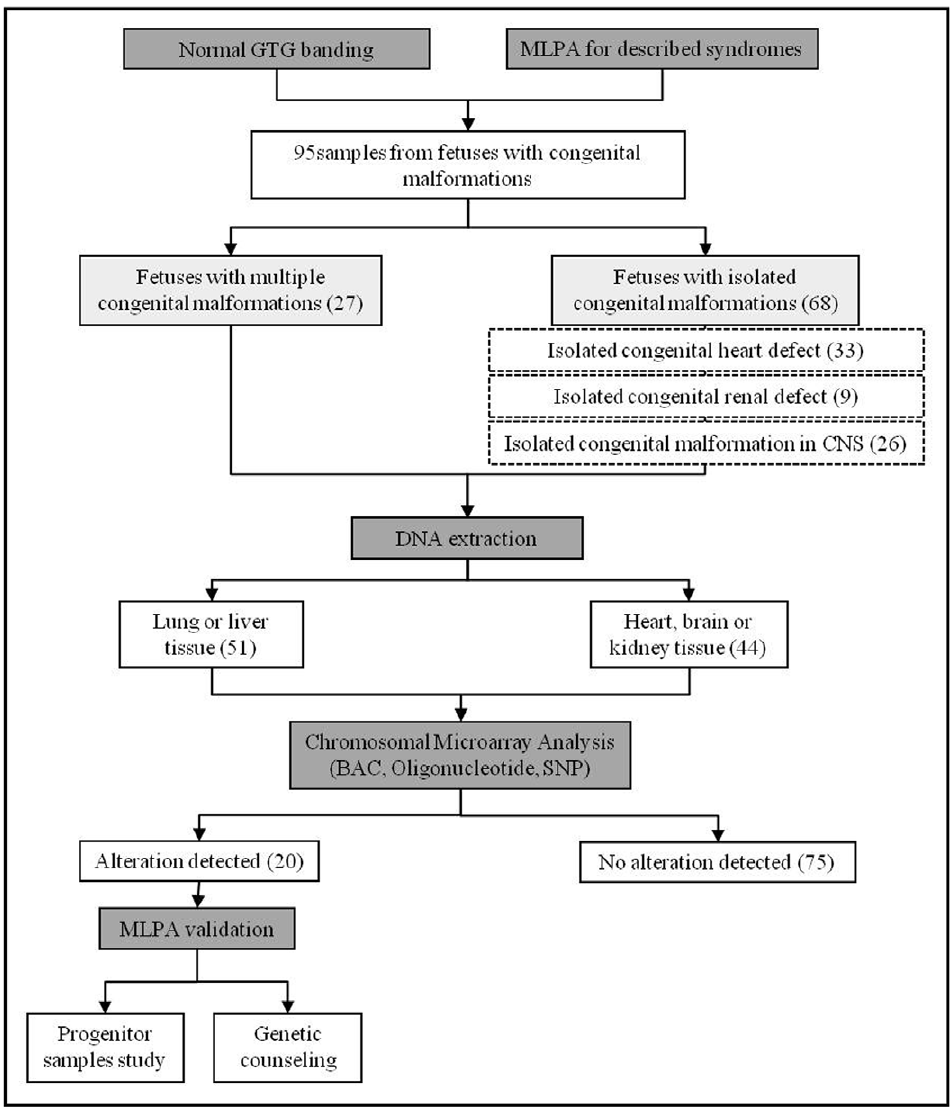
Figure 1. Strategy followed to study samples of fetuses with congenital malformations. MLPA: multiplex ligation-dependent probe amplification; CNS: central nervous system; BAC: bacterial artificial chromosome; SNP: single nucleotide polymorphism.